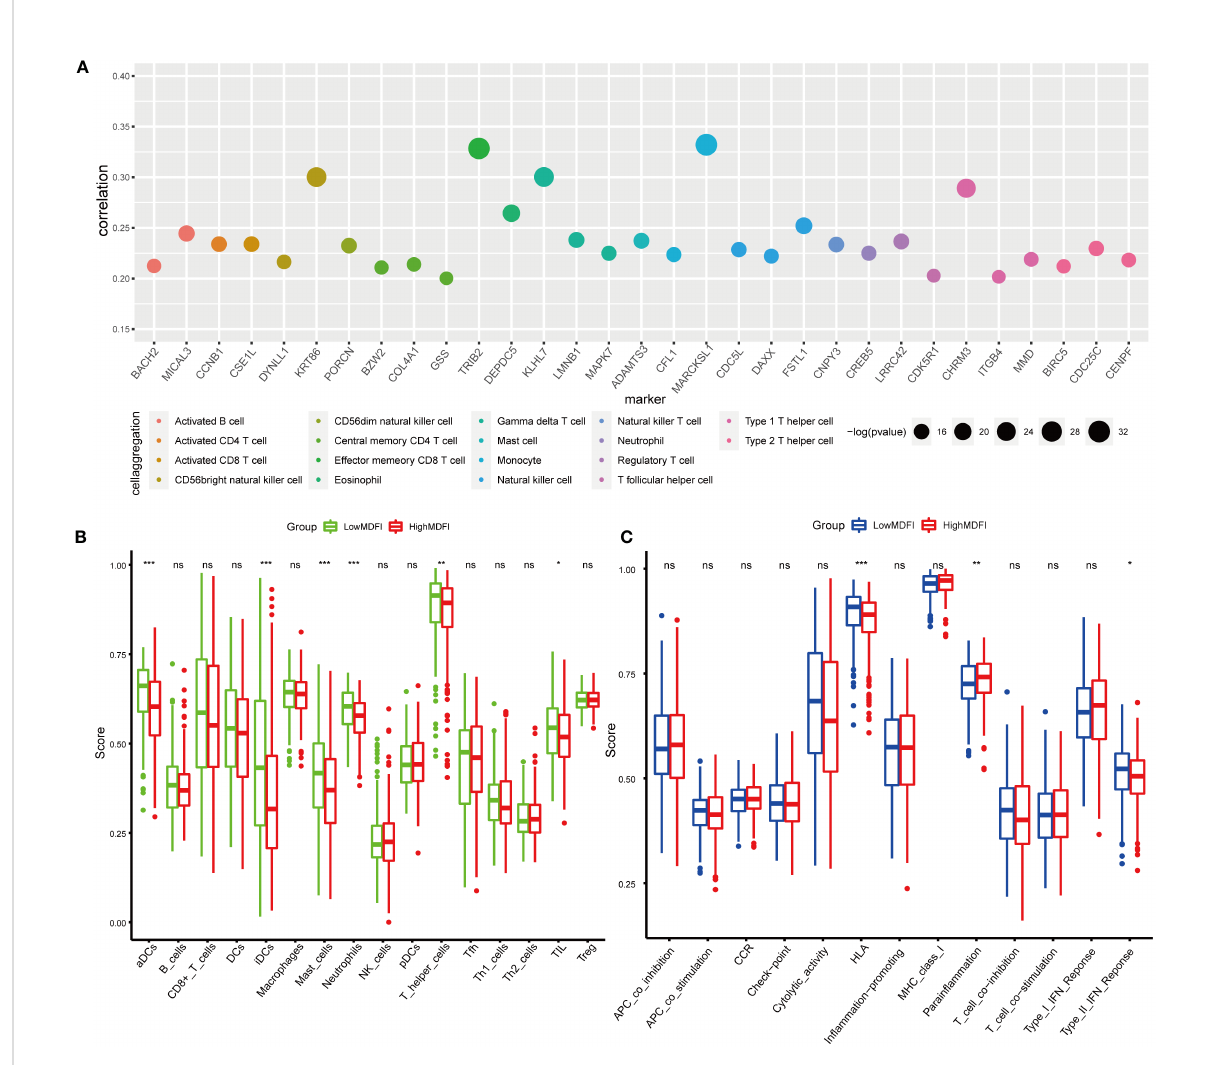
FIGURE 4 Immuno-in fi ltration analysis of MDFI in LUAD, data from TCGA, (A) Maker genes of immune cells associated with MDFI, (B) Relationship between the expression pro fi le of MDFI and immune cells, (C) Relationship between the expression pro fi le of MDFI and immune function. *p < 0.05, **p < 0.01, ***p < 0.001, ns, p >